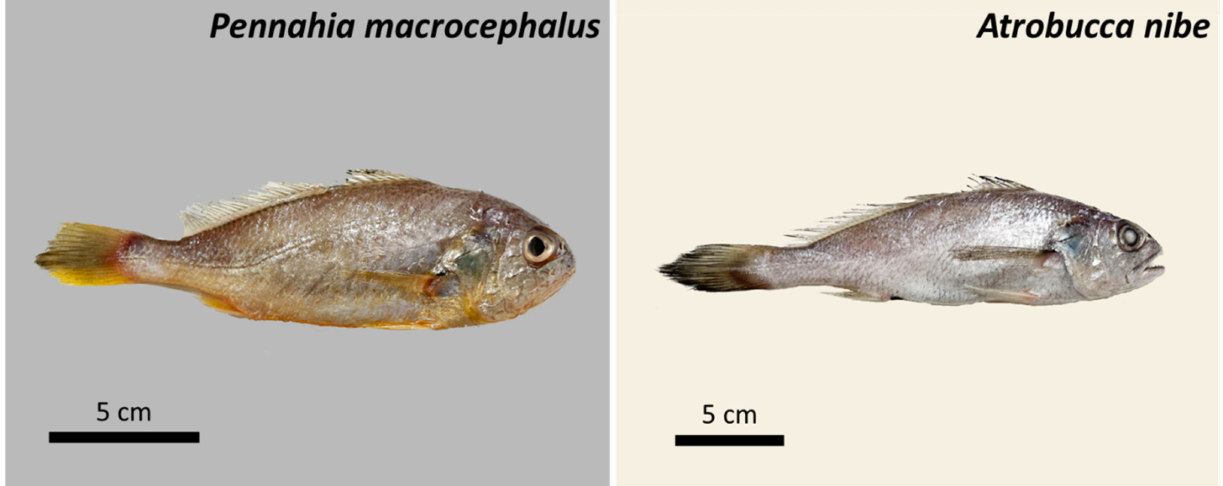
Figure 1. Two important croaker species occurred in Taiwan. Pennahia macrocephalus (big-head pennah croaker, age = 3.5) and Atrobucca nibe (blackmouth croaker, age =